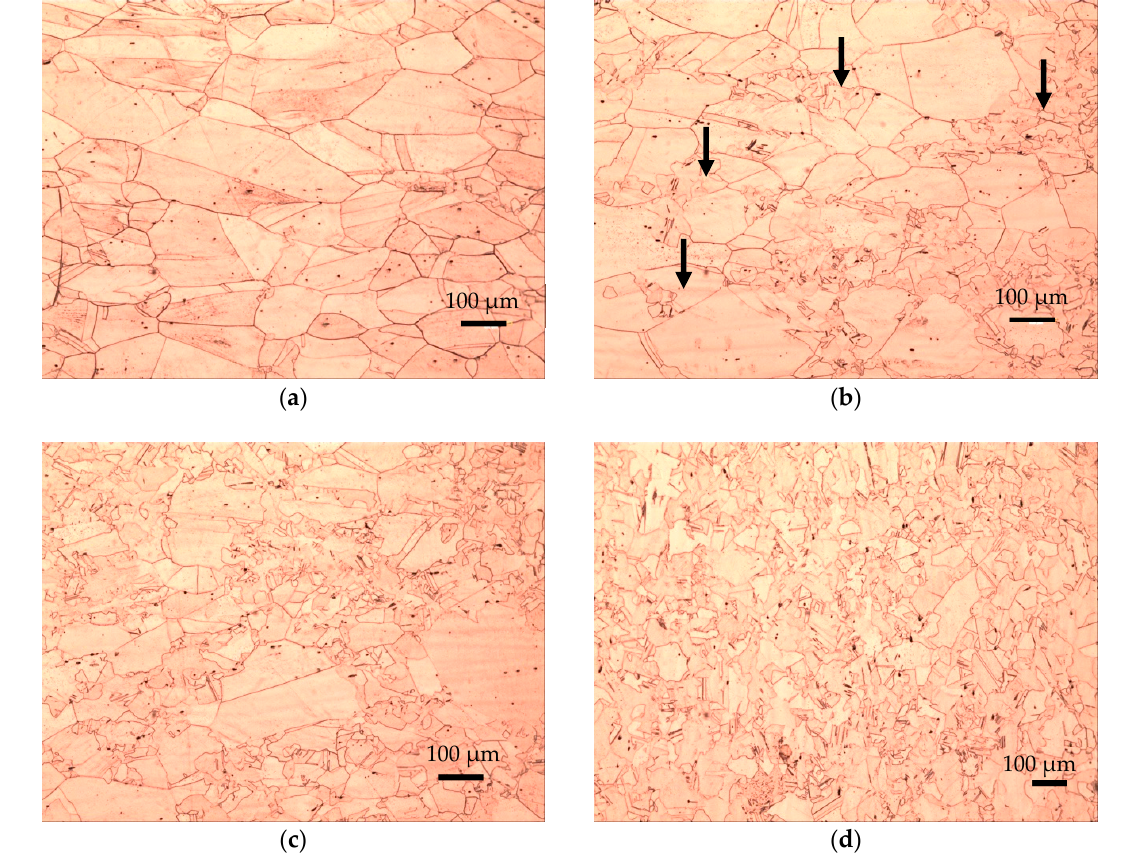
Figure 6. Microstructure evolution in the 160 µm initial grain size material at ( a ) 25 s, unrecrystallised; ( b ) 40 s, 20% recrystallised; ( c ) 90 s, 50% recrystallised; and ( d ) 160 s, fully recrystallised at 850 °C, 0.3 strain. The arrows in (b) show recrystallisation nuclei preferentially located at grain boundaries and triple points.